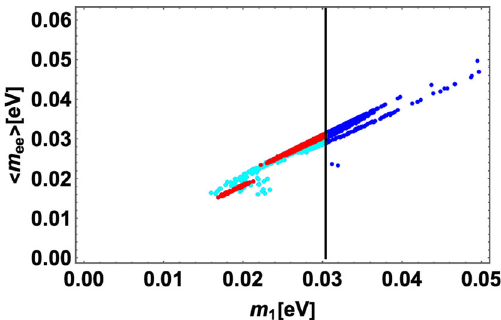
Fig. 8 Predicted effective mass (cid:2) m ee (cid:3) of the 0 νββ decay versus m 1 for NH. The vertical line is the upper-bound of m 1 , which is derived from the cosmological bound, 120meV. Colors of points correspond to points of τ in Fig. 4